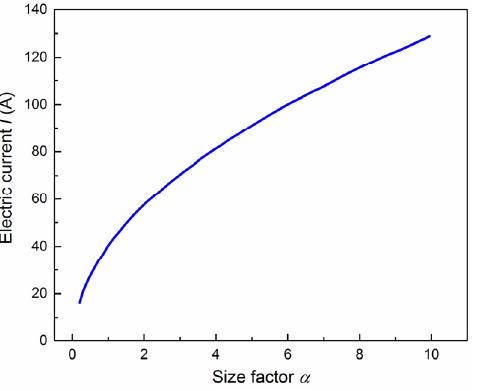
Figure 5. The relationship between electric current and size factor at the specimen temperature of 500 °C.